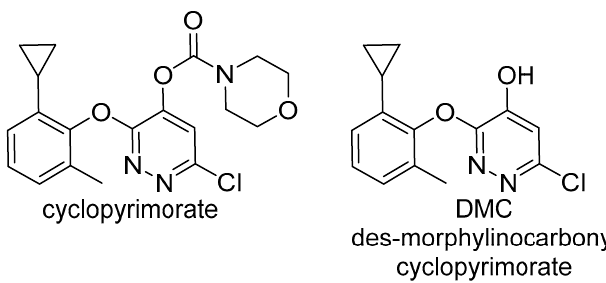
Figure 4. Cyclopyrimorate and its bioactive metabolite des-morpholinocarbonyl cyclopyrimorate (DMC).